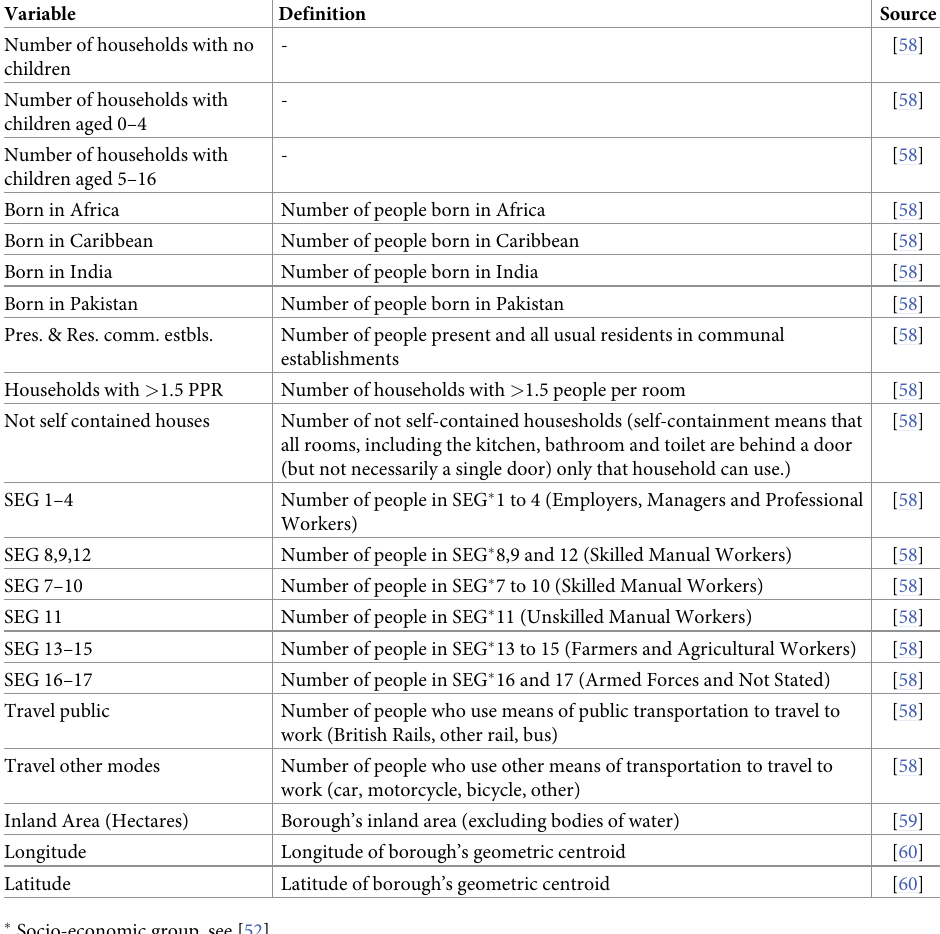
Table 1. Description of geographic and census variables used in this